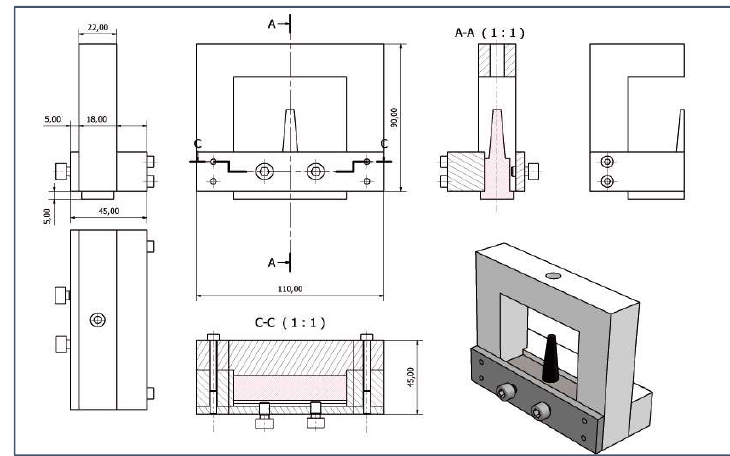
Figure 3. Homemade designed Probe-Holder.